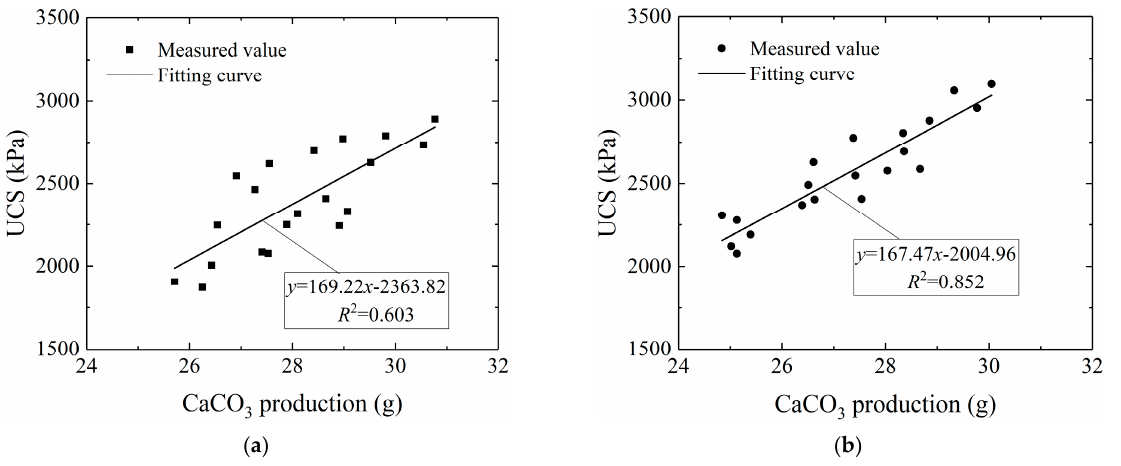
Figure 8. Curves of unconfined compressive strength versus CaCO 3 content ( a ) ρ d = 1.5 g/cm 3 ; and ( b ) ρ d = 1.6 g/cm 3.